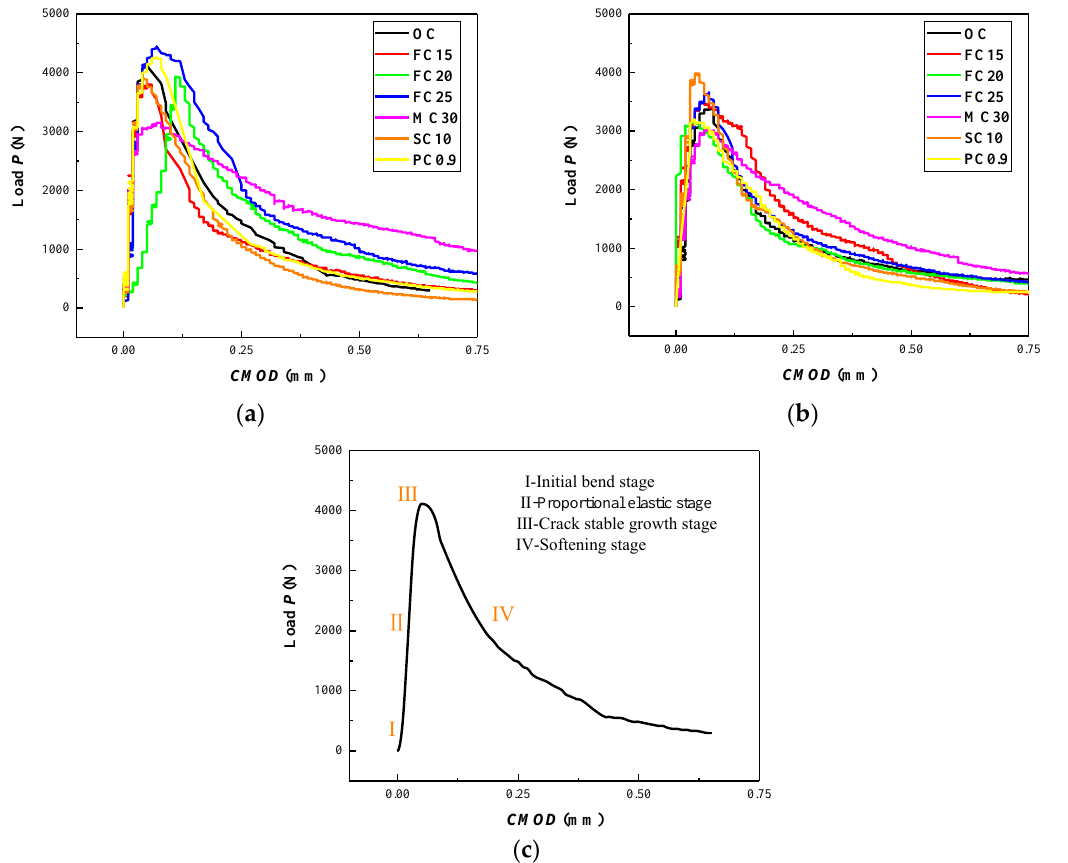
Figure 5. The load-crack opening displacement (P-CMOD) curve of eroded concrete in the ( a ) sixth and ( b ) twelfth dry–wet cycles. ( c ) P-CMOD characteristic curve.